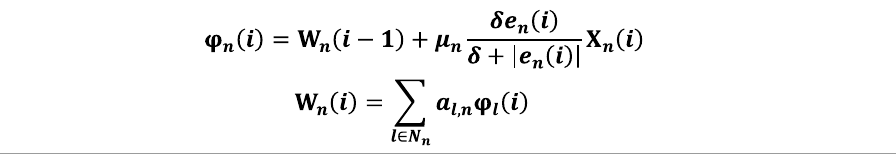
Table 1. The DFair algorithm